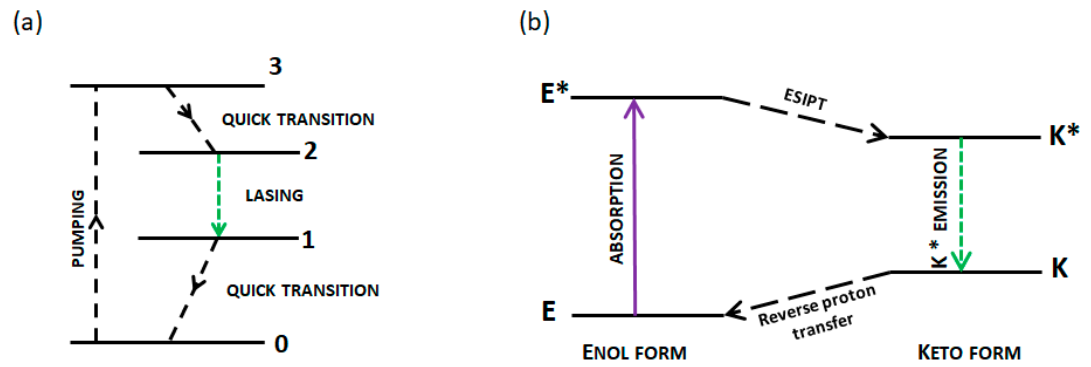
Figure 1. Energy diagrams of ( a ) the four-level laser system and ( b ) the excited-state intramolecular proton transfer (ESIPT) photocycle.